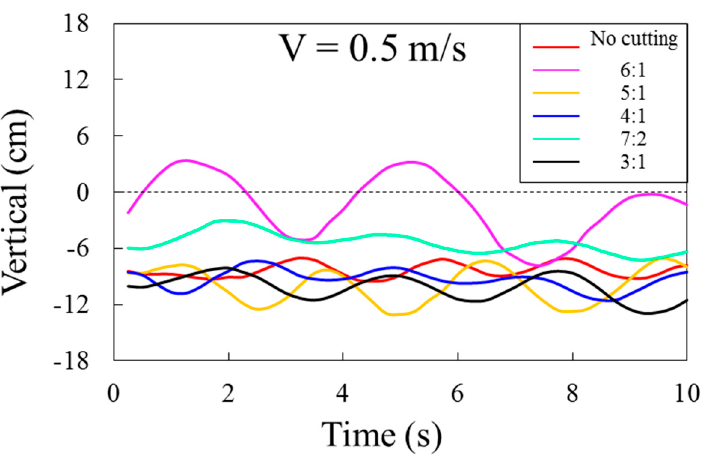
Figure 8. Variations of the end point height for codends with catch in different cutting ratios.